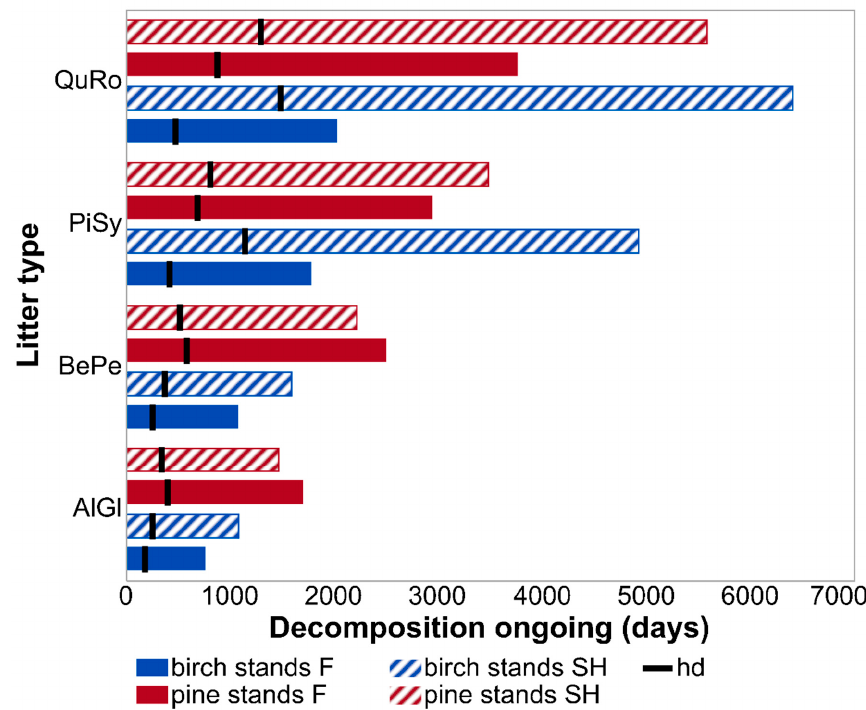
Figure 2. Decomposition rates ( k constants) of litter of four species decomposed in birch and pine stands growing on two different site types—post-mining external spoil heap (SH) or forest sites (F). Abbreviations: AlGl— Alnus glutinosa ; BePe— Betula pendula ; PiSy— Pinus sylvestris ; QuRo— Quercus robur .